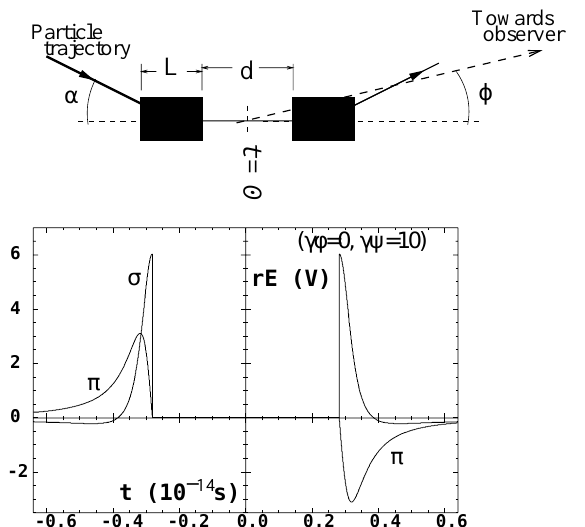
FIG. 4. Top: dipoles with interfering ends. Bottom: typical shape of the electric field; the time symmetry breaks when gw fi 0 .